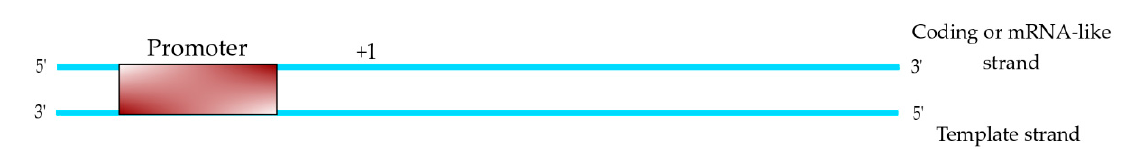
Figure 1. Description of the DNA template. The top strand is the coding strand or RNA-like strand, while the bottom strand is the template strand. + 1 is the transcription start